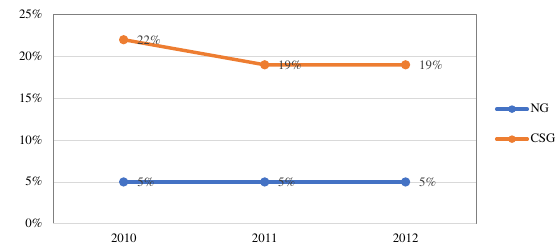
Fig. 3 Net asset salvage value rate of CSG and